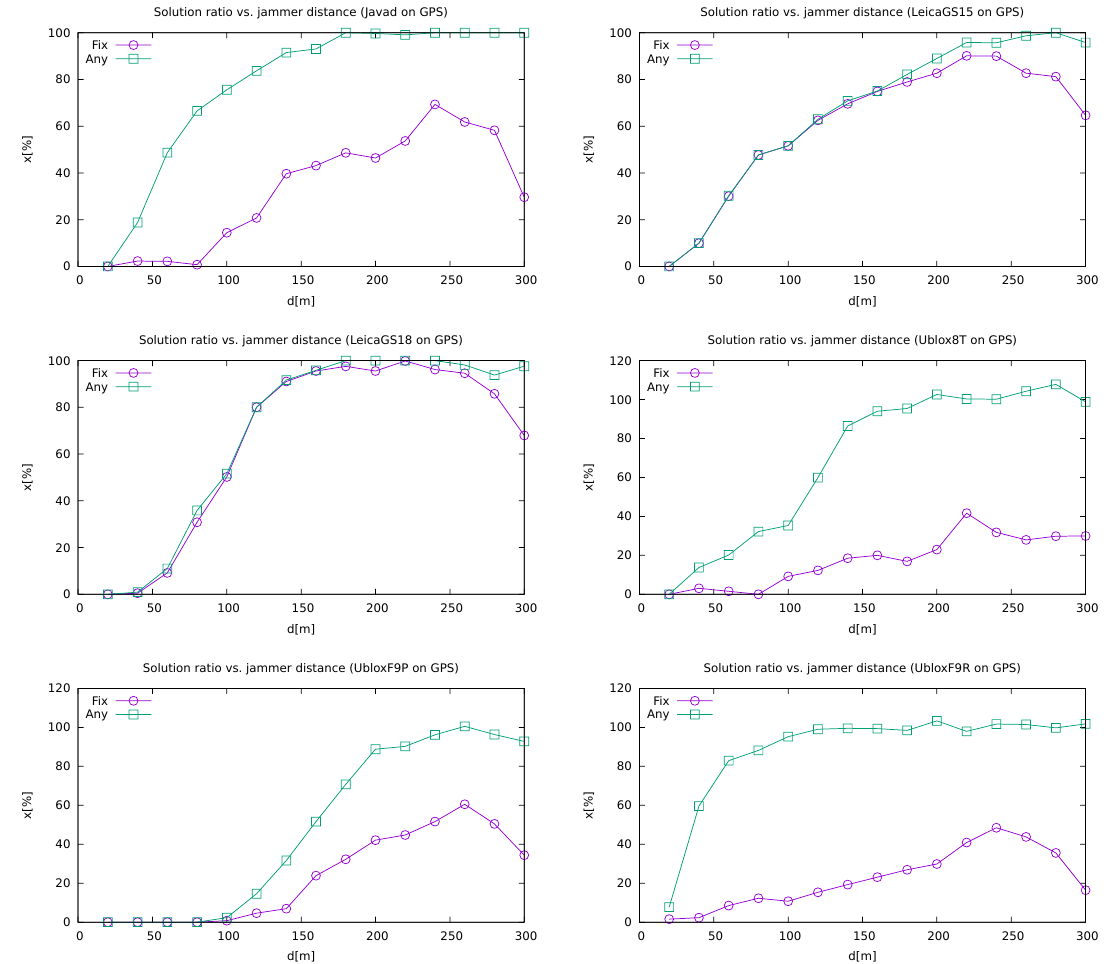
Figure 10. Quality reporting of different receivers depending on the jammer distance (non-cumulative) when using GPS only (own study, from the collection